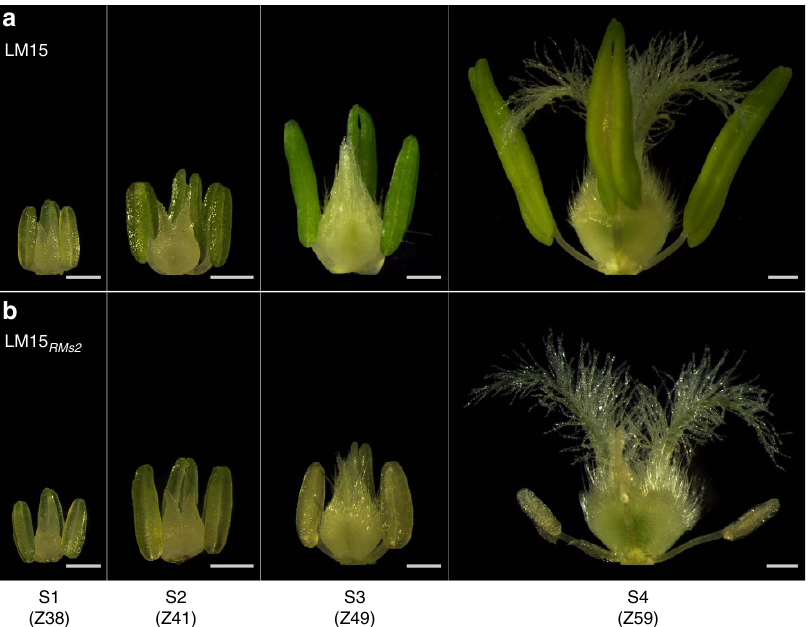
Figure 1 | Typical anther growth in Taigu lines. ( a ) Wild-type male-fertile LM15. ( b ) Male-sterile Taigu LM15 RMs2 . LM15 RMs2 is characterized by diminutive stamens and wild-type pistils. Anther growth was divided into four developmental stages (S1 to S4). Codes in parentheses indicate a comparable Zadok’s scale 37 . The experiment was repeated three times. Scale bars,